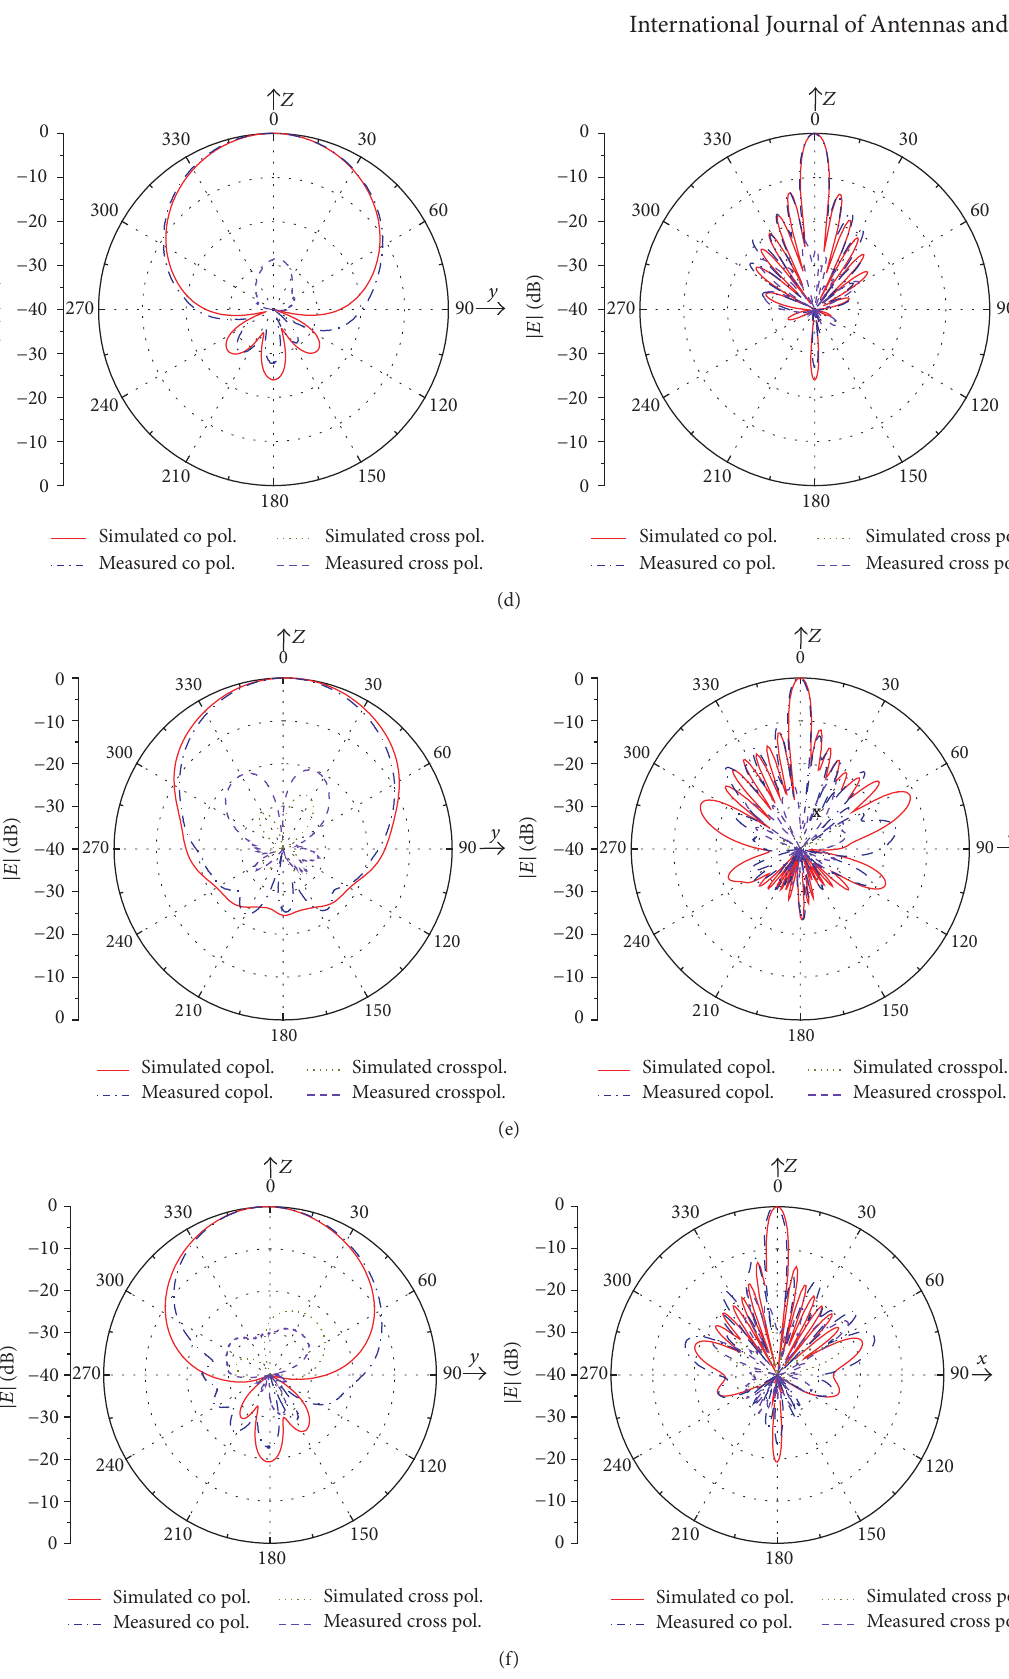
Figure 10: Radiation patterns of the V/H dual-polarized antenna array: (a) VP at 1.7 GHz; (b) HP at 1.7GHz; (c) VP at 2.2 GHz; (d) HP at 2.2 GHz; (e) VP at 2.7 GHz; (f) HP at 2.7